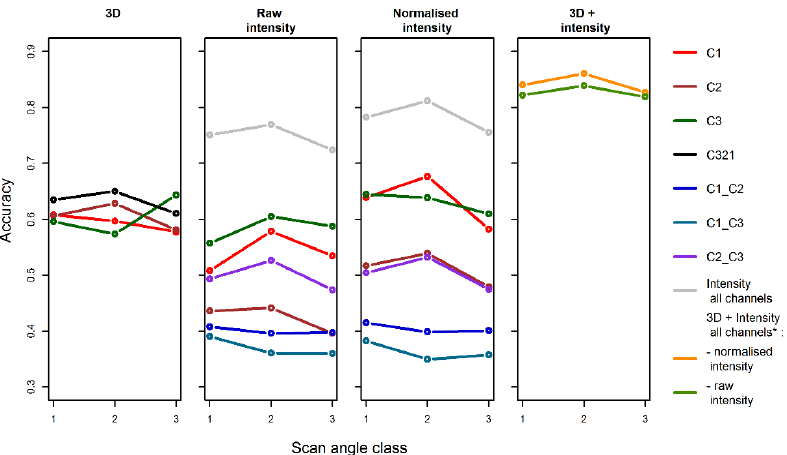
Figure 9. Random forest species identification accuracy by scan angle class. * Channels used in “3D + intensity” are C321 for 3D and C1, C2, C3, C1_C2, C1_C3, C2_C3 for intensity. Table 7. Improvement in accuracy between classifications using normalized intensity features com- pared to classifications using raw intensity features. Results are presented as overall (second col- umn) and by mean scan angle class (columns 3 – 5), for classifications with different feature selection (rows). Cases that were improved by ≥ 0.10 are highlighted in grey.